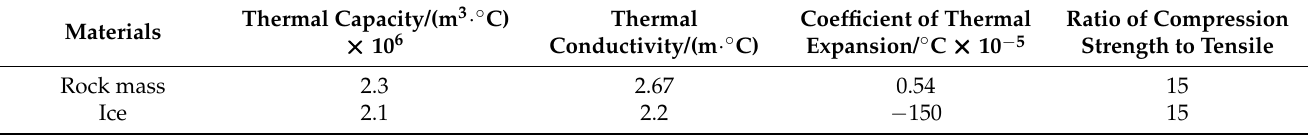
Table 3. The thermodynamic parameters of the numerical